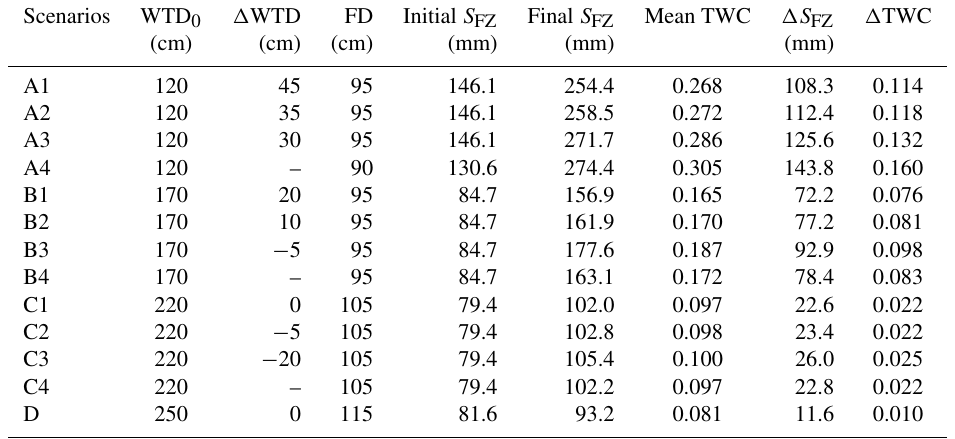
Figure 8. The evolutions of simulated total water content, frost depth, and water table depth under three different initial water table depths (120, 170, and 220cm) and four different groundwater supply conditions. Table 4. A comparison of water table decline ( (cid:49) WTD), frost depth (FD), and water gain in the frozen zone under different scenarios.